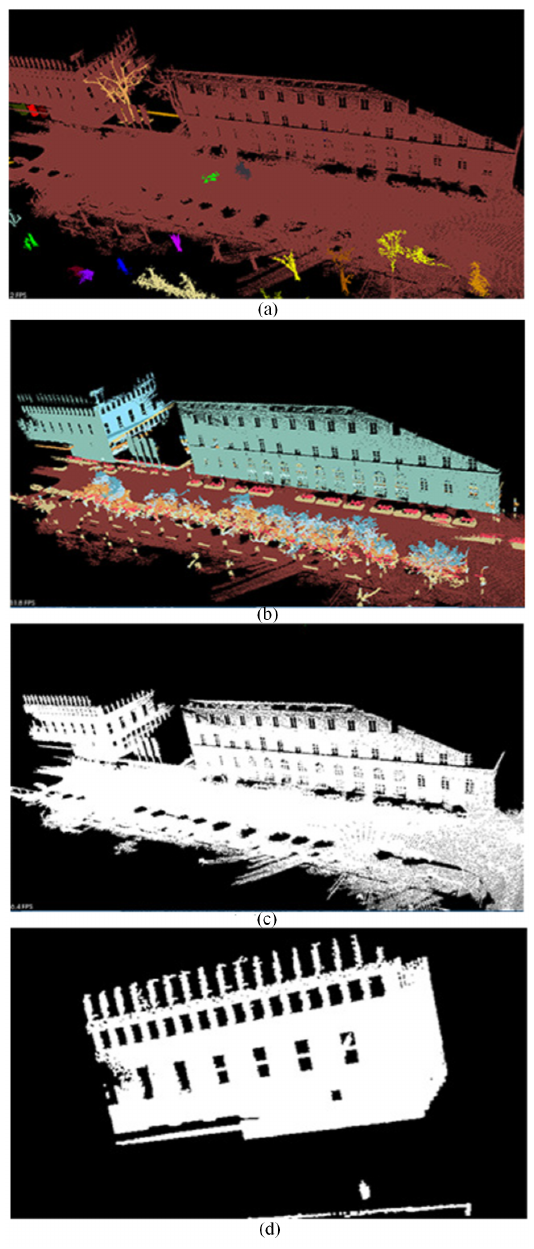
Figure 5. Point clouds after segmentation. (a) Result after the first Euclidean cluster extraction. (b) Segmentation after plane segmentation by Sample Consensus method. (c) Final result after segmentation. (d) An example of scene cropping.